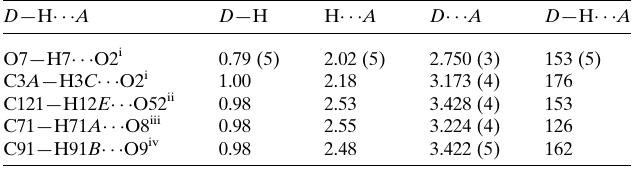
Table 2 Hydrogen-bond geometry (A˚ , (cid:3) ).